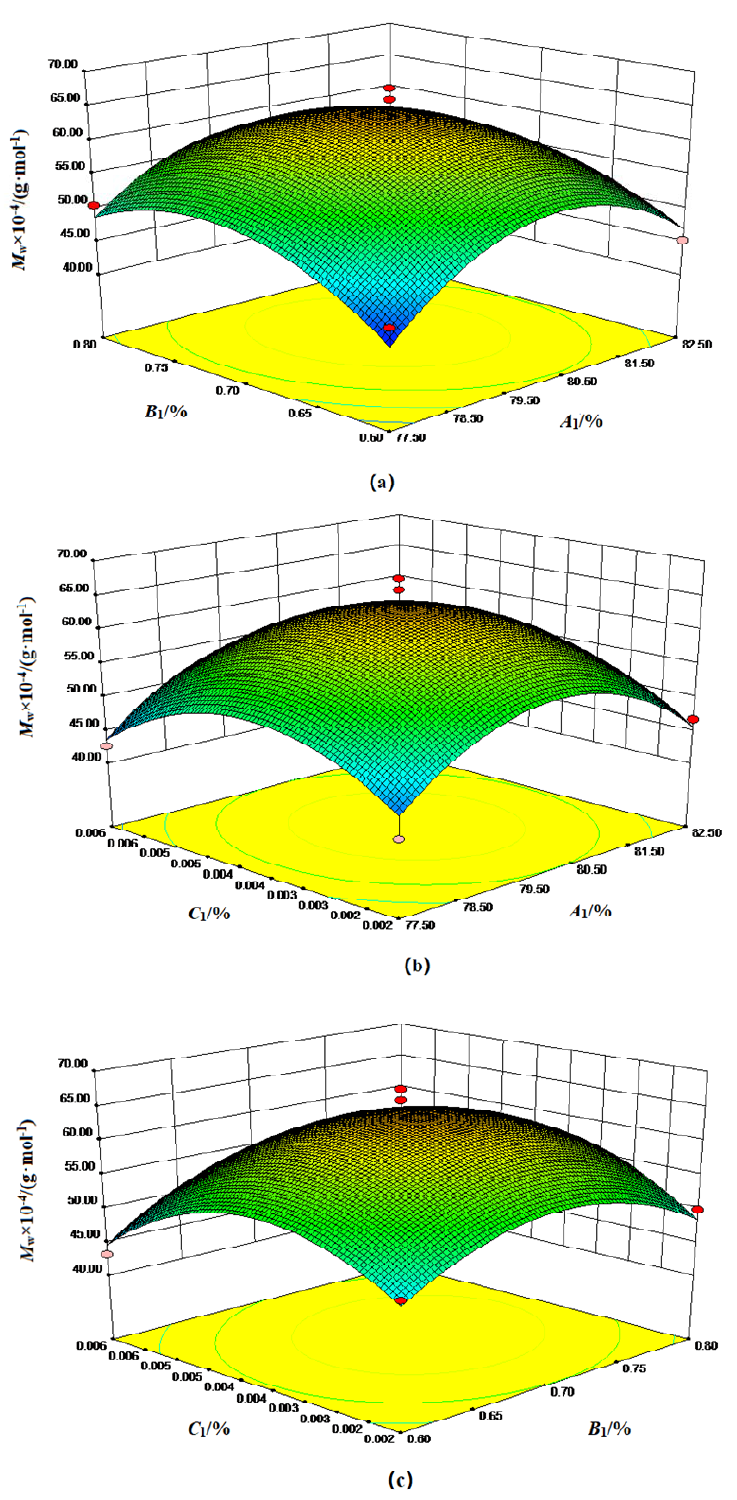
Figure 3. Response surface diagram of the interaction effect of various factors of the polymerization process feed ratio on M w . ( a ) Response surface diagram of the interaction between A 1 and B 1 of the polymerization process on M w ; ( b ) Response surface diagram of the interaction between A 1 and C 1 of the polymerization process on M w ; ( c ) Response surface diagram of the interaction between B 1 and C 1 of the polymerization process on M w.